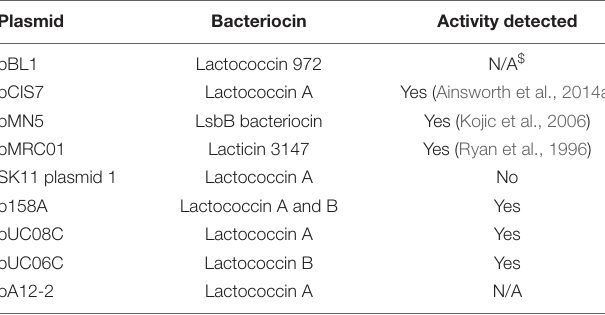
TABLE 3 | Predicted plasmid-encoded antimicrobial